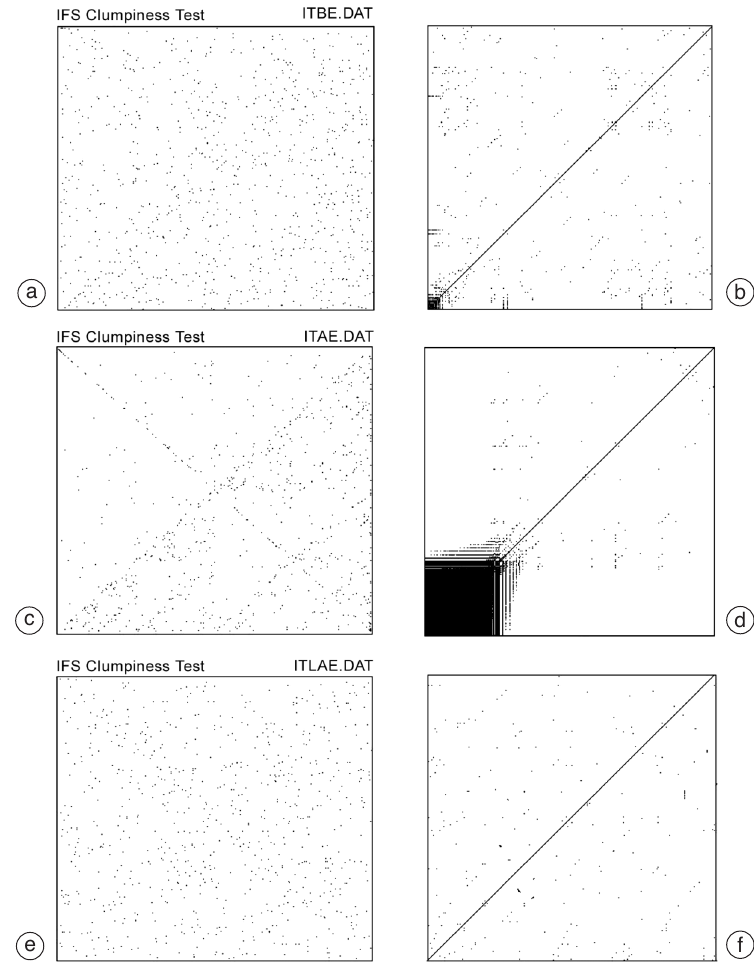
Fig. 7a-f. Qualitative analysis of 1000 data waiting times sequences (complete catalogue), after largest events before beginning of EM experiments (1975-1983), during experiments (1983-1988) and after accomplishing of experiments (1988-1992). IFS-clumpiness test for inter-event time interval sequences: a) before experiments; c) during experiments; e) after experiments. Recurrence plots analysis of waiting times sequences: b) before exper- iments; d) during experiments; f) after